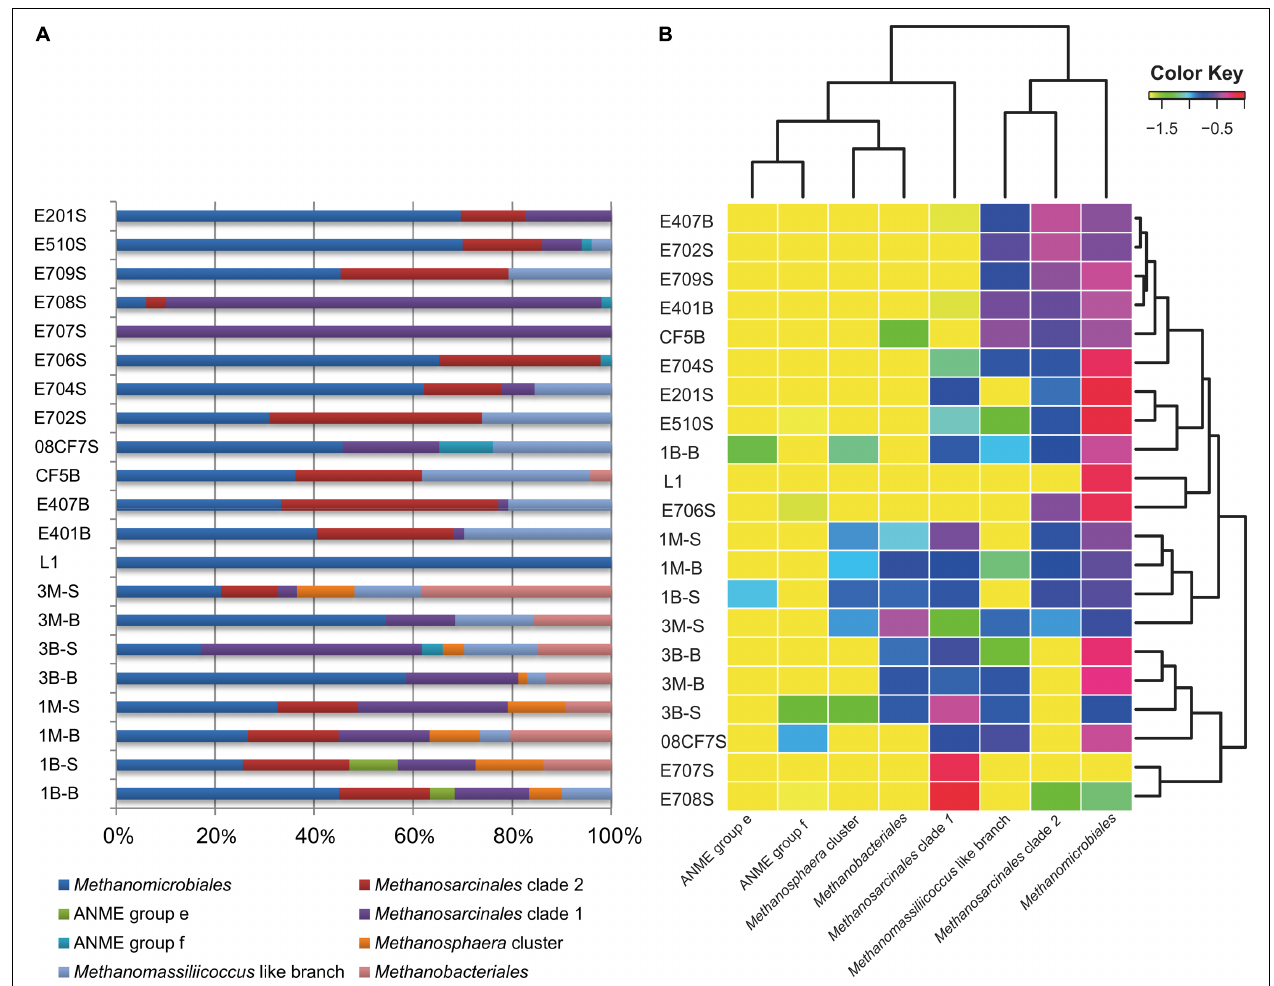
cluster most resembling archaea groups on horizontal axis, most similar sample in respect of community composition on vertical axis. Depicted color key indicated the log-transformed values of abundance percentage values in each sample. This heatmap was generated by extracted R script from skiff module in CloVR software under Rstudio